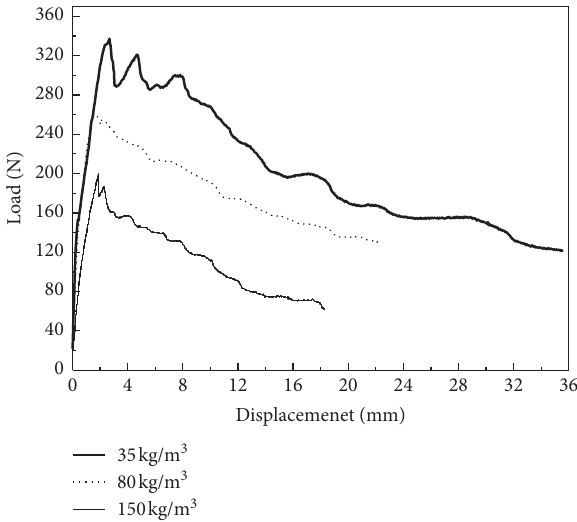
Figure 8: Load-displacement curves of DCB specimens.